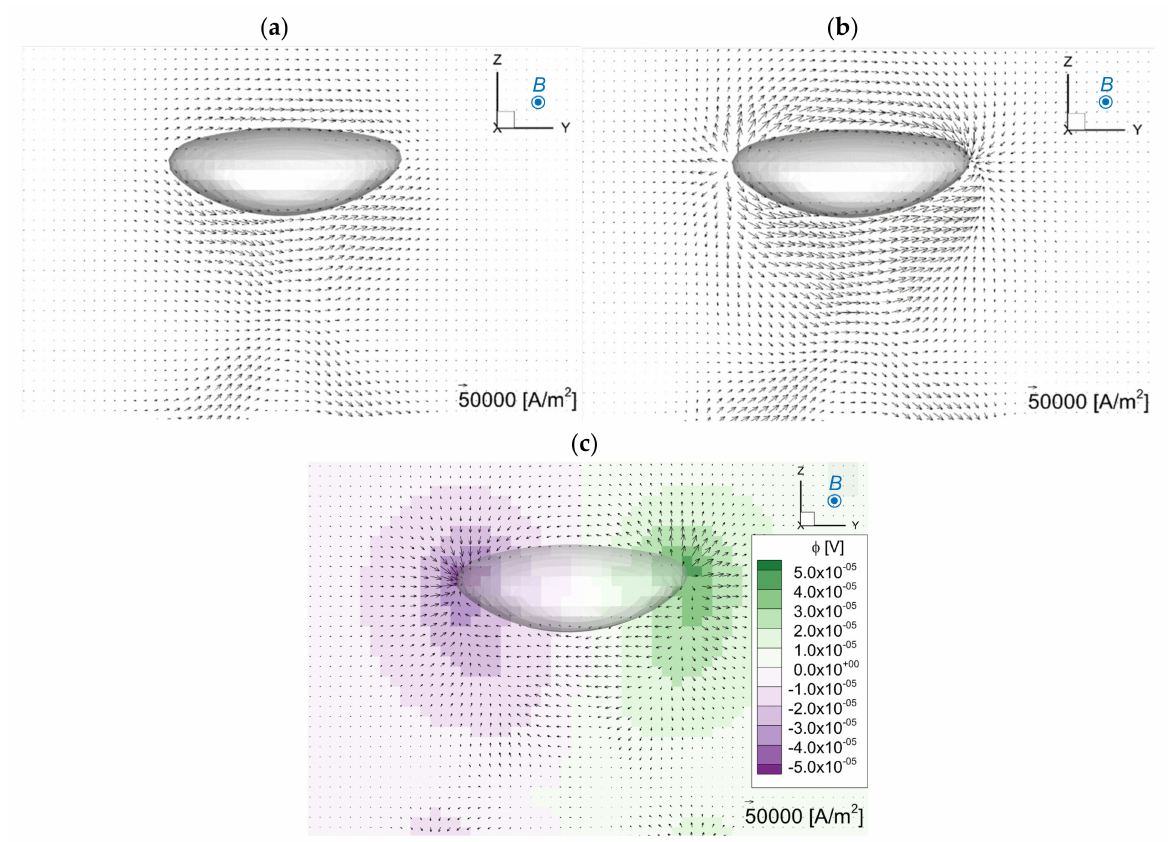
Figure 24. Distributions of the electric current vector and its components in the x = 0 plane for B 0 = 0.14 T : ( a ) j , ( b ) j and ( c ) j together with the electric potential φ as the color contour. The B φ distribution of j generally resembles that of j B